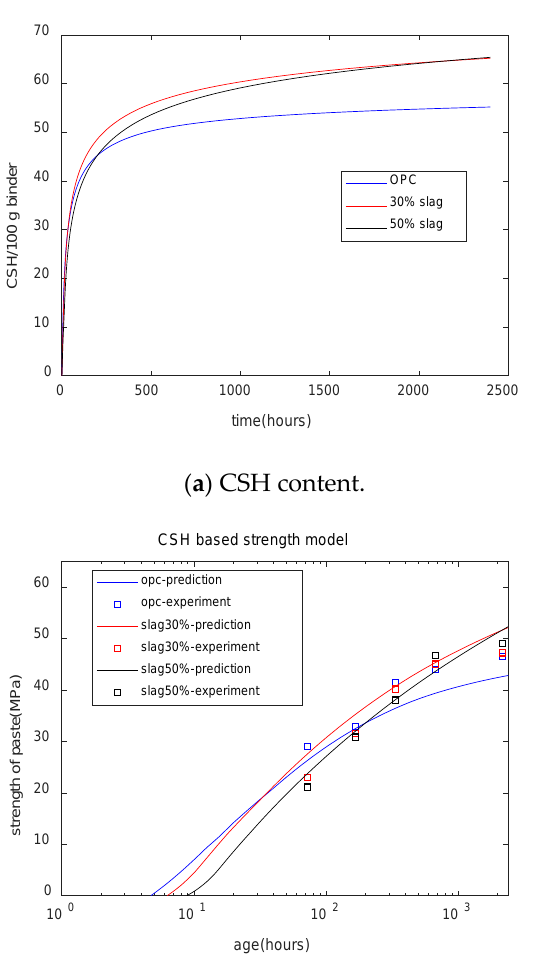
Figure 10. CSH-based strength